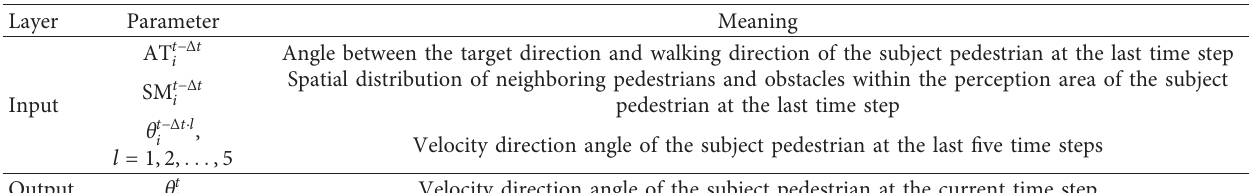
Table 2: Inputs and outputs of the